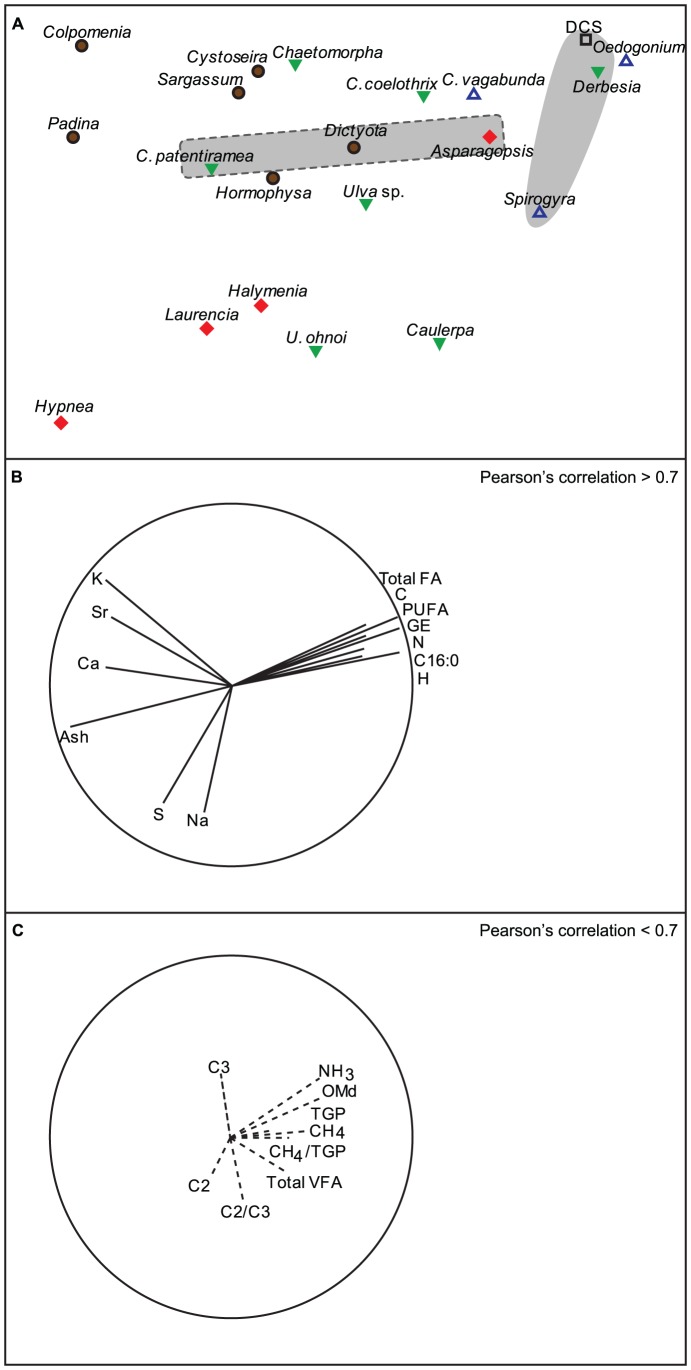
MDS showing similarities between macroalgae species based on biochemical and post-fermentation parameters.(A) MDS plot (Stress = 0.11) of the distribution of species within ordination space. Species within grey cluster had the highest TGP and CH4 production, while species within dotted line grey cluster had the lowest TGP and CH4 production. (B) MDS vectors with Pearson's correlation coefficients (r) higher than 0.7 superimposed. (C) Post-fermentation parameters vectors superimposed (note all correlation coefficients lower than 0.7, see Table 2). White and blue triangles: Freshwater green algae, green triangles: Marine green algae, brown circles: Brown algae, red diamonds: Red algae, and square: DCS. Species full names are given in Table 1.